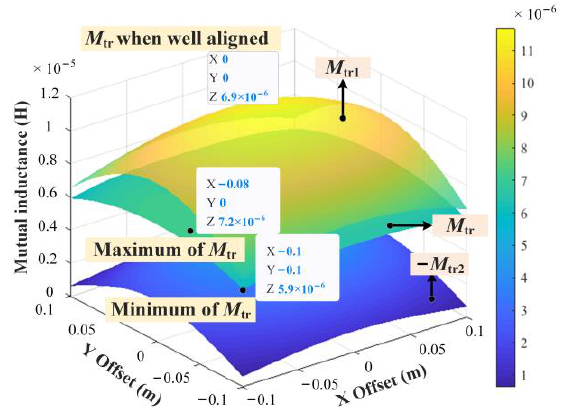
Figure 7. Offset characteristic maps in all directions without employing cores.